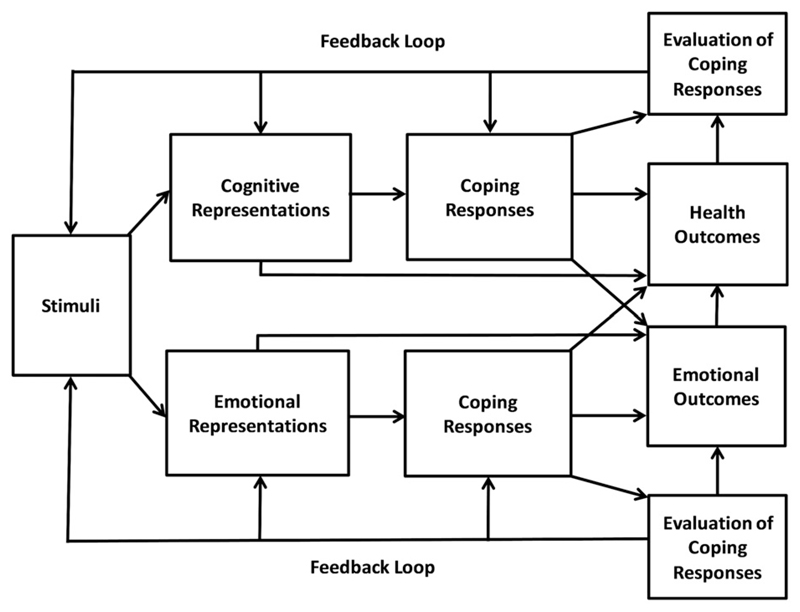
Leventhal’s (1980) Self-regulatory model. This figure has been adapted from Hagger and Orbell (2003).